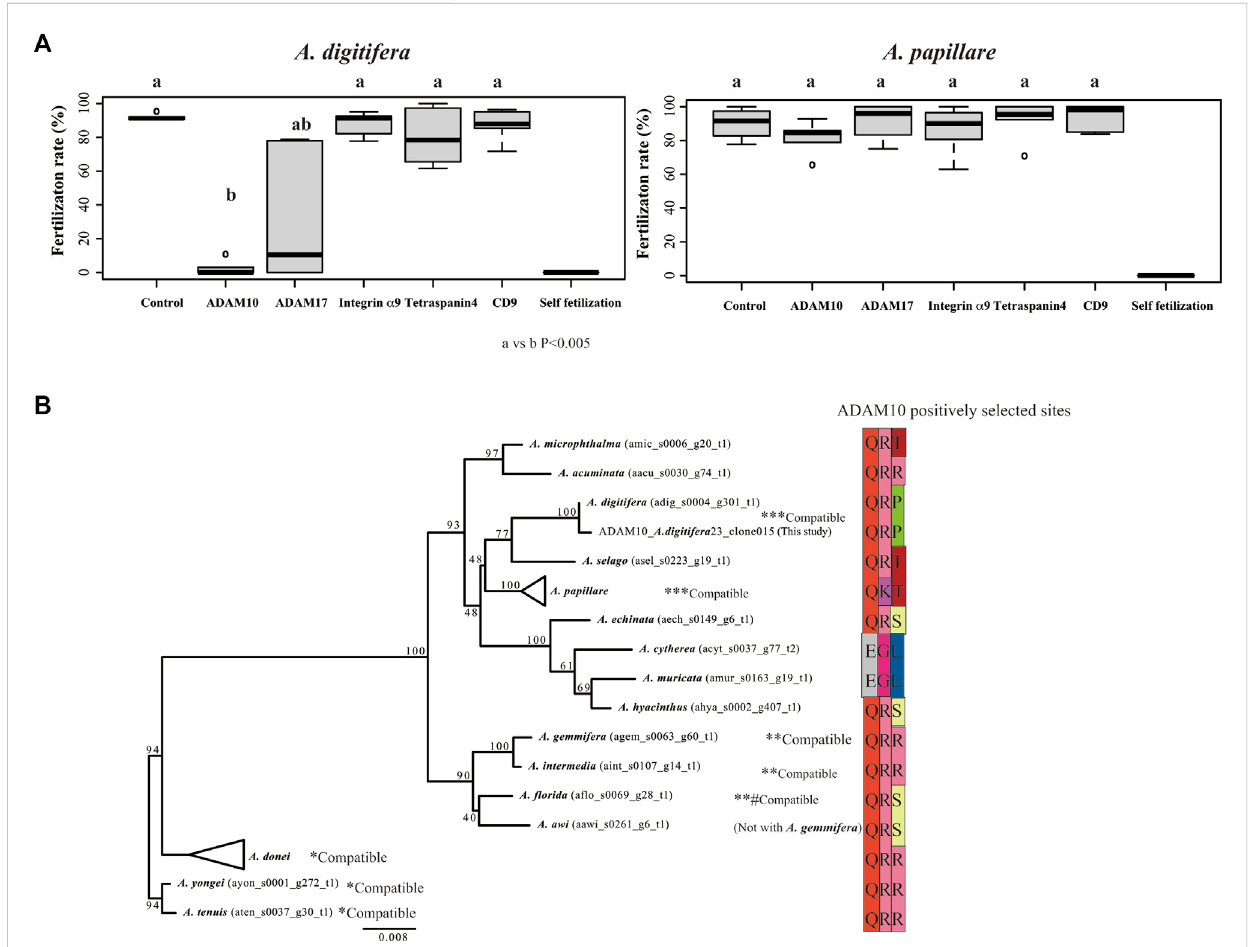
FIGURE 3 Fertilization ratio in the presence of antibodies against tetraspanins, integrin α 9, and ADAMs. Fertilization in the presence of 10 μ L of each antibody (1 mg/mL IgG) in 1 mL seawater ( fi nally 10 μ g/mL) was observed in gametes from Acropora digitifera and A. papillare . (A) Fertilization was conducted at 106 sperm/mL conditions, and the mixture of the gametes was fi nished within 2 h of spawning. Six crosses using gametes from three colonies of each species( N =6;threecoloniesfromboth A.digitifera and A.papillare ).Self-fertilizationwasusedasanegativecontrol. (A) or (B) indicatesasigni fi